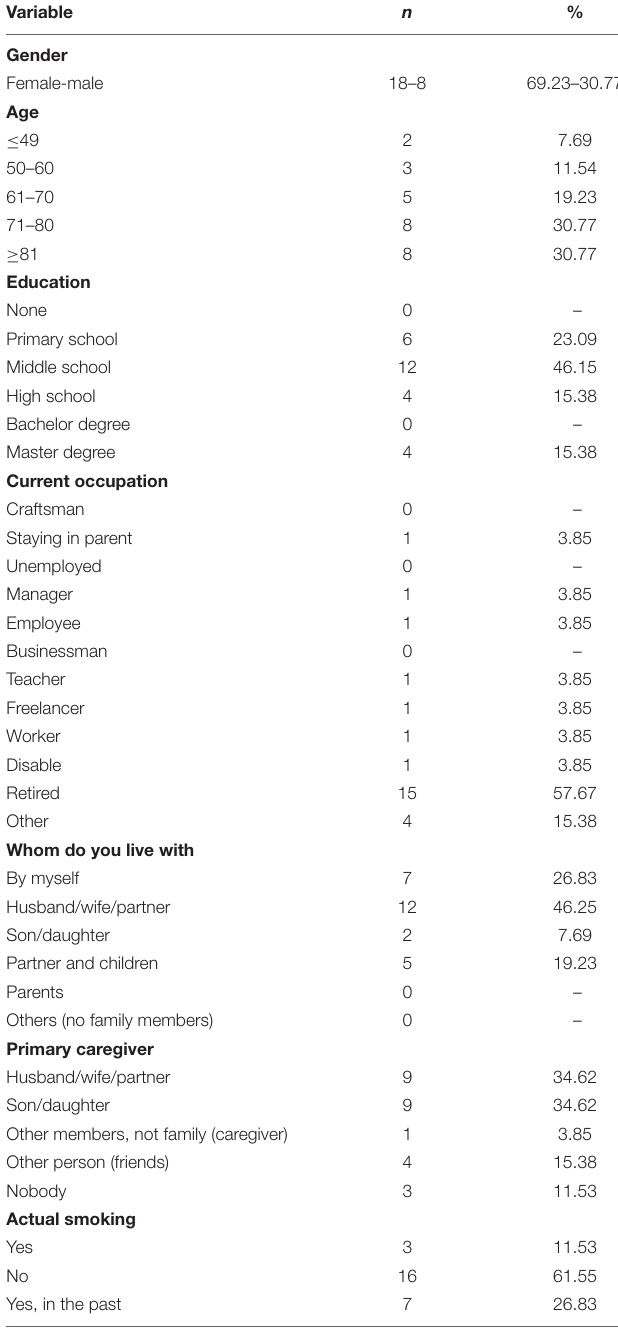
TABLE 1 | Socio-demographic characteristics of patients ( n =